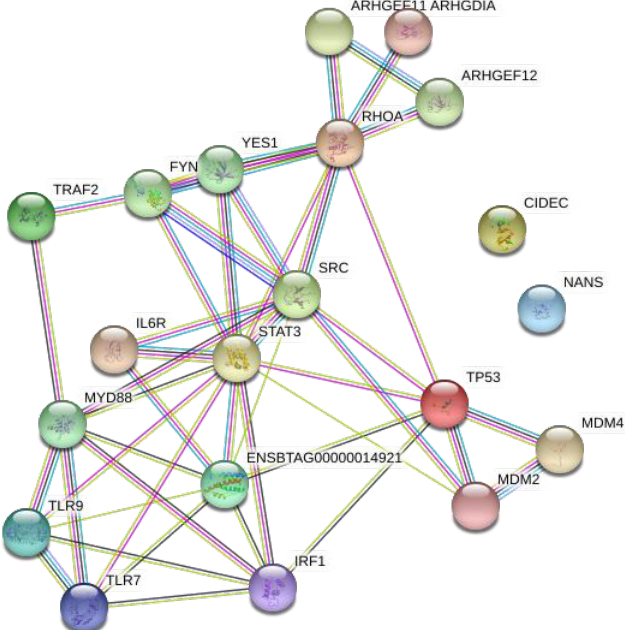
Figure 4. Network analysis of predicted genes. Protein-protein interaction network of immune genes associated with BCoV. (Edge color legend; blue: from curated database, pink: experimentally determined, green: text mining, brown: co-expression).